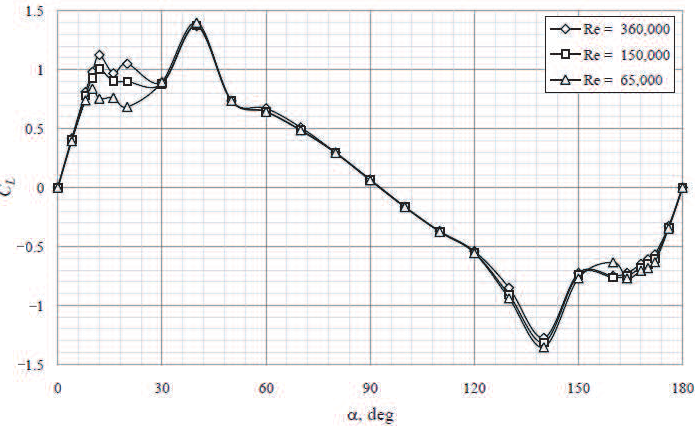
Figure 21. Lift as a function of AOA at varying Reynolds numbers.